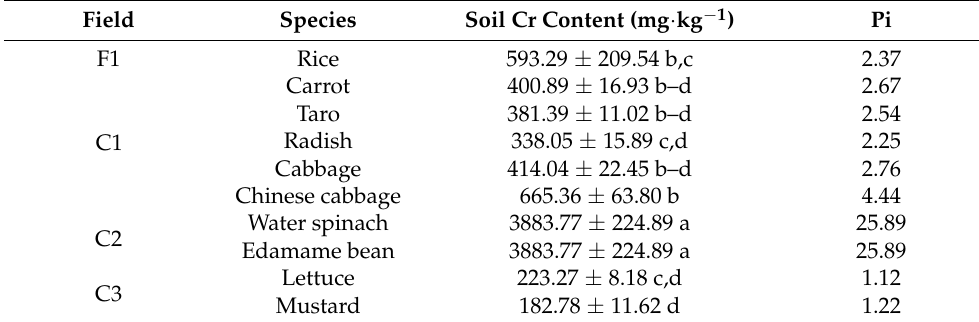
Table 1. Cr content and pollution index of rhizosphere